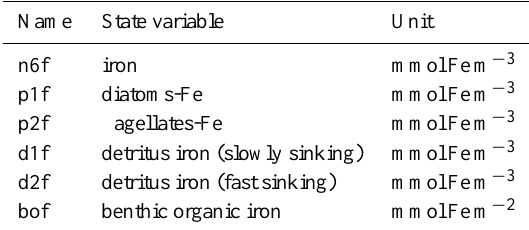
Table A1. Iron-related state variables of the biological submodel, the acronyms used within the equations and their